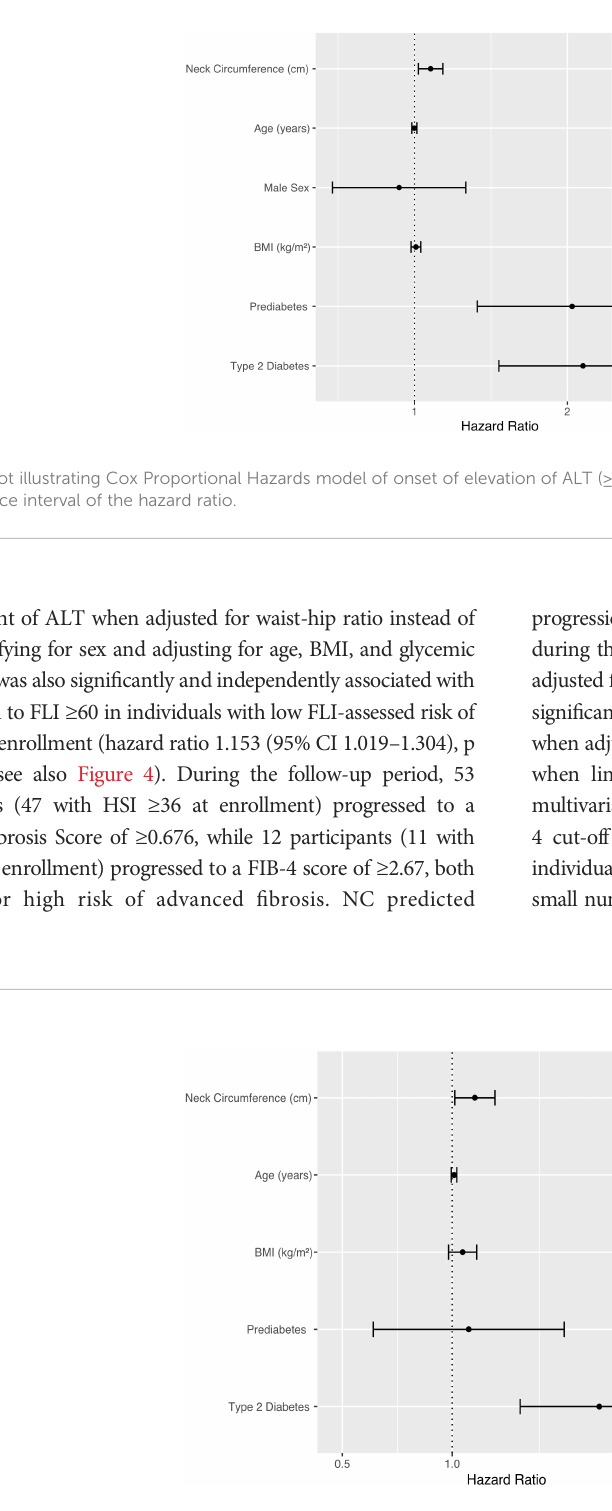
FIGURE 4 Forest plot illustrating Cox Proportional Hazards model of time to fi rst FLI ≥ 60 in individuals with FLI <60 at enrolment. Error bars represent the 95% con fi dence interval of the hazard